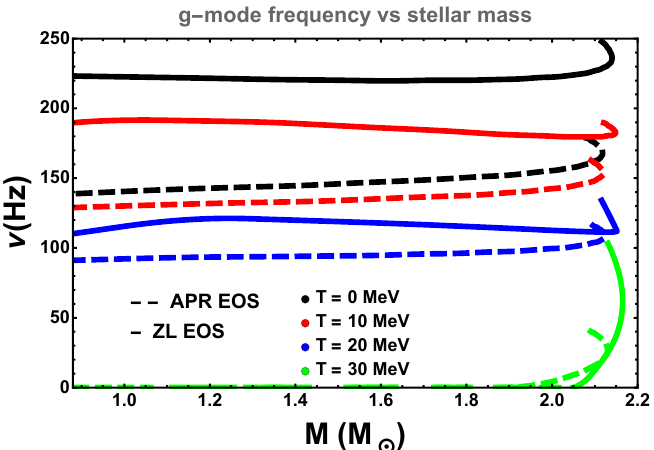
Figure 1. Plots of the g-mode frequencies as a function of the star’s mass (in solar masses). As tem- perature increases, g-mode frequencies are suppressed. At temperatures of 30 MeV, g-modes vanish except near the maximum mass, and eventually these disappear as well with increasing